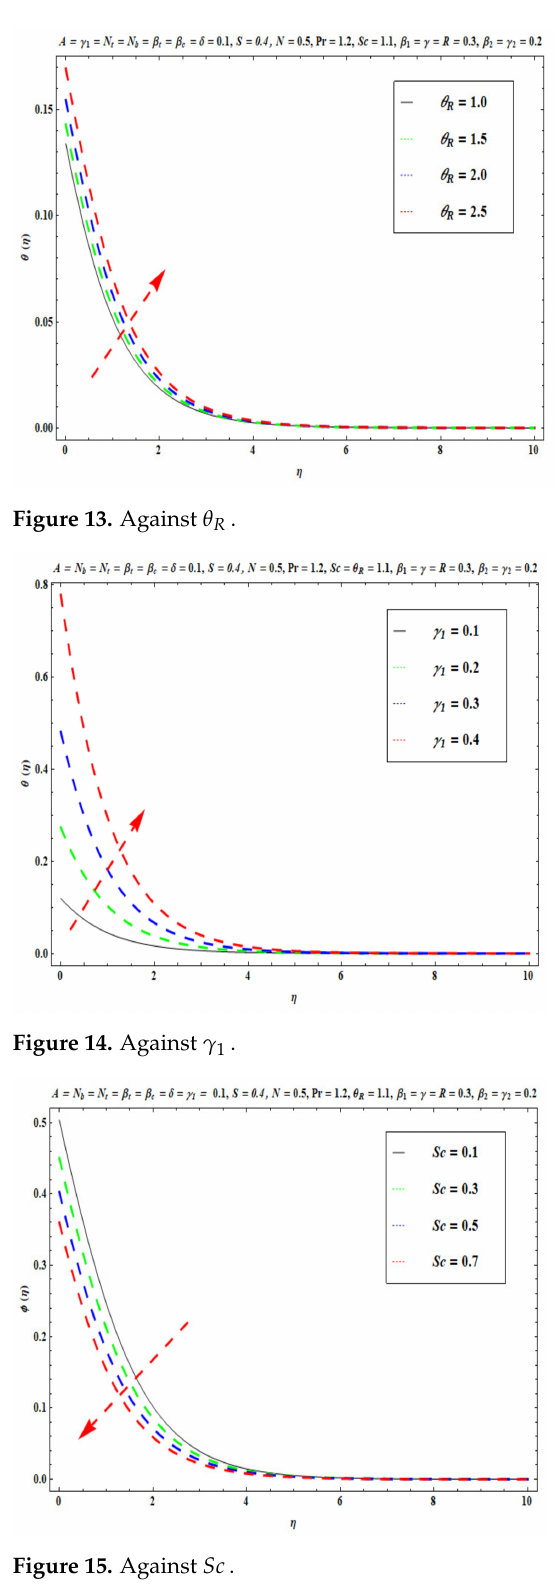
Figure 15. Against Sc